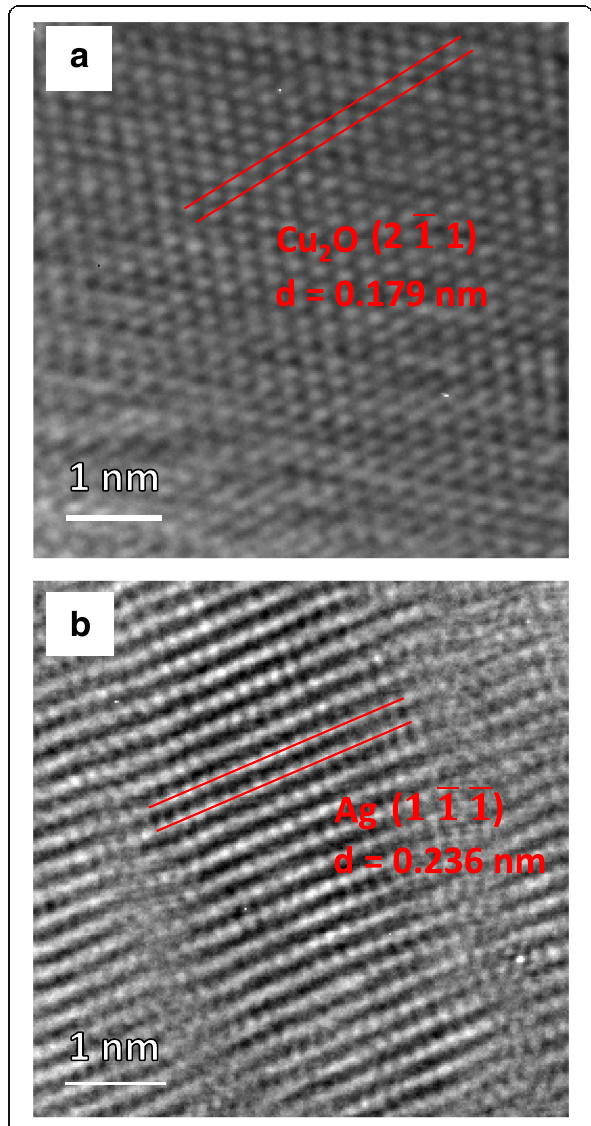
Fig. 4 a , b High-resolution TEM images of a Cu 2 O NP and an Ag NP,